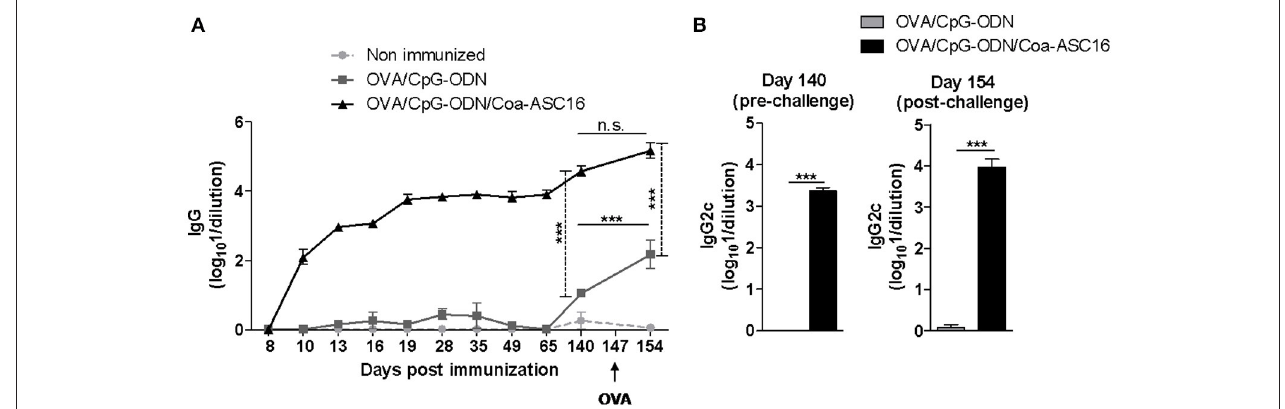
FIGURE 4 | The nanostructured formulation elicits long-lasting humoral response with a single-dose immunization. C57BL/6 mice were immunized on day 0 with OVA/CpG-ODN or OVA/CpG-ODN/Coa-ASC16. On day 147 after immunization, mice were intraperitoneally challenged with OVA. Plasma samples were collected at different time points for determination of OVA-specific antibodies titers by ELISA. (A) Kinetics in plasma of OVA-specific IgG. (B) OVA-specific IgG2c on days 140 (pre-challenge) and 154 (post-challenge) after immunization. The data show the mean ± SEM of individual values (4 mice/treatment group in each experiment) and are representative of two independent experiments performed. *** p < 0.001, n.s., not significant.